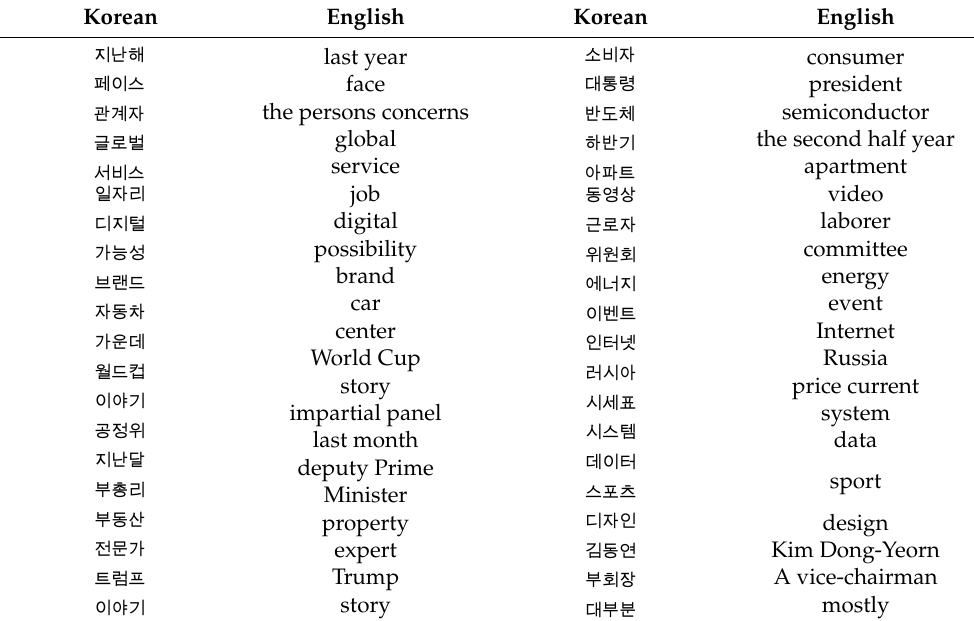
Figure 14. Big data visualization of terms frequently appearing in the “social” category. Table 1. Translation of the big data visualization of the Top 40 categories.